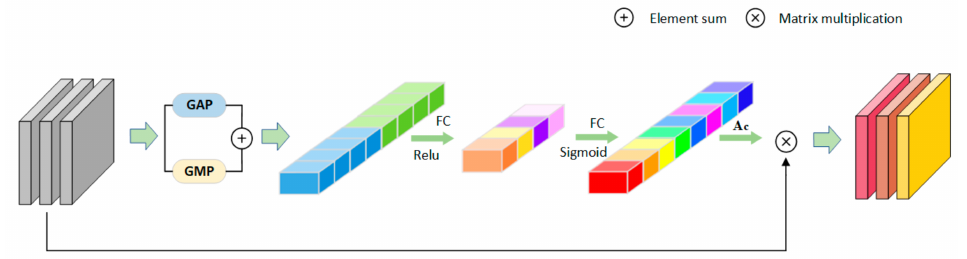
Figure 3. The structure of CAB. Position-Wise Attention Block: Figure 4 is a position-wise attention framework. PAB